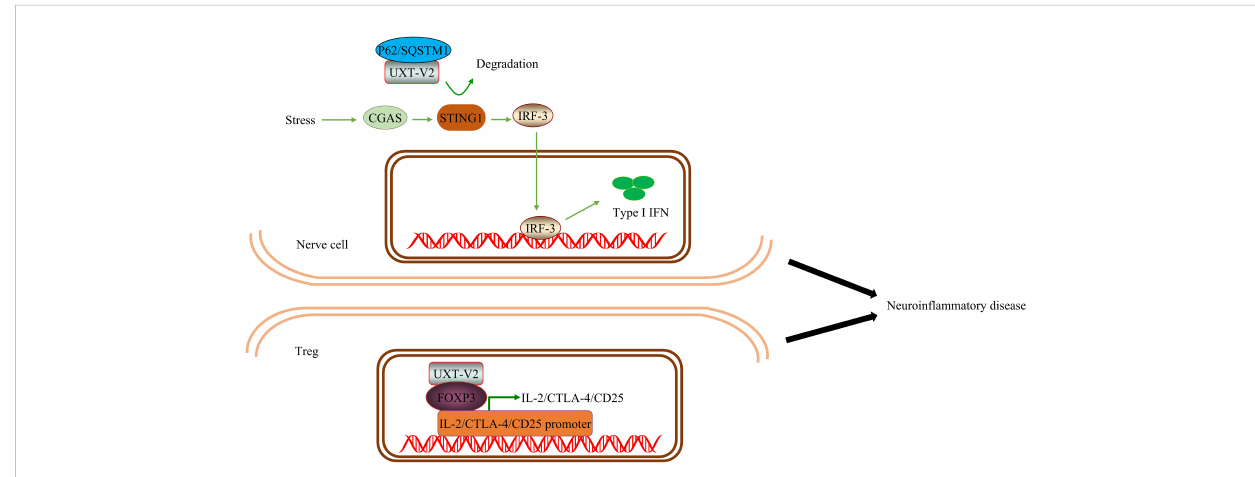
FIGURE 9 UXT regulates neuroin fl ammation in ALS: UXT-V2 down regulates the expression of type I IFN by autophagy degradation of STING1 mediated by P62. UXT-V2 promoted the inhibitory phenotype of Tregs by binding to FOXP3. Together, they improve neuroin fl ammation in neurodegenerative